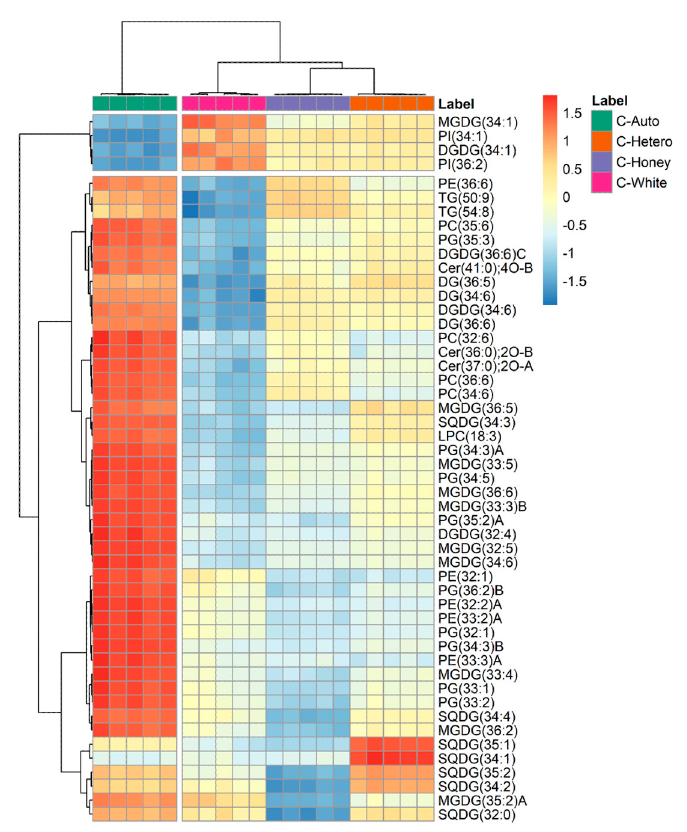
Figure 4. Two − dimensional hierarchical clustering analysis and heatmap containing the top 50 most discriminating lipids (one-way ANOVA, q < 0.05) identified in 4 strains of Chlorella vulgaris (C − Auto, C − Hetero, C − Honey, and C − White). Relative abundance levels are indicated on the colour scale, with numbers indicating the fold difference from the mean. The clustering of sample groups is represented by the dendrogram at the top. The clustering of individual lipid species considering their similarity in relative abundance is represented by the dendrogram on the left. Letters A, B, and C refer to different combinations of esterified fatty acids within the same molecular species, which can be found in Supplementary Table S1. Abbreviations: DGDG, digalactosyldiacylglycerol; MGDG, monogalactosyldiacylglycerol; SQDG, sulfoquinovosyldiacylglycerol; PC, phosphatidyl- choline; LPC, lysophosphatidylcholine; PE, phosphatidylethanolamine; PG, phosphatidylglycerol;